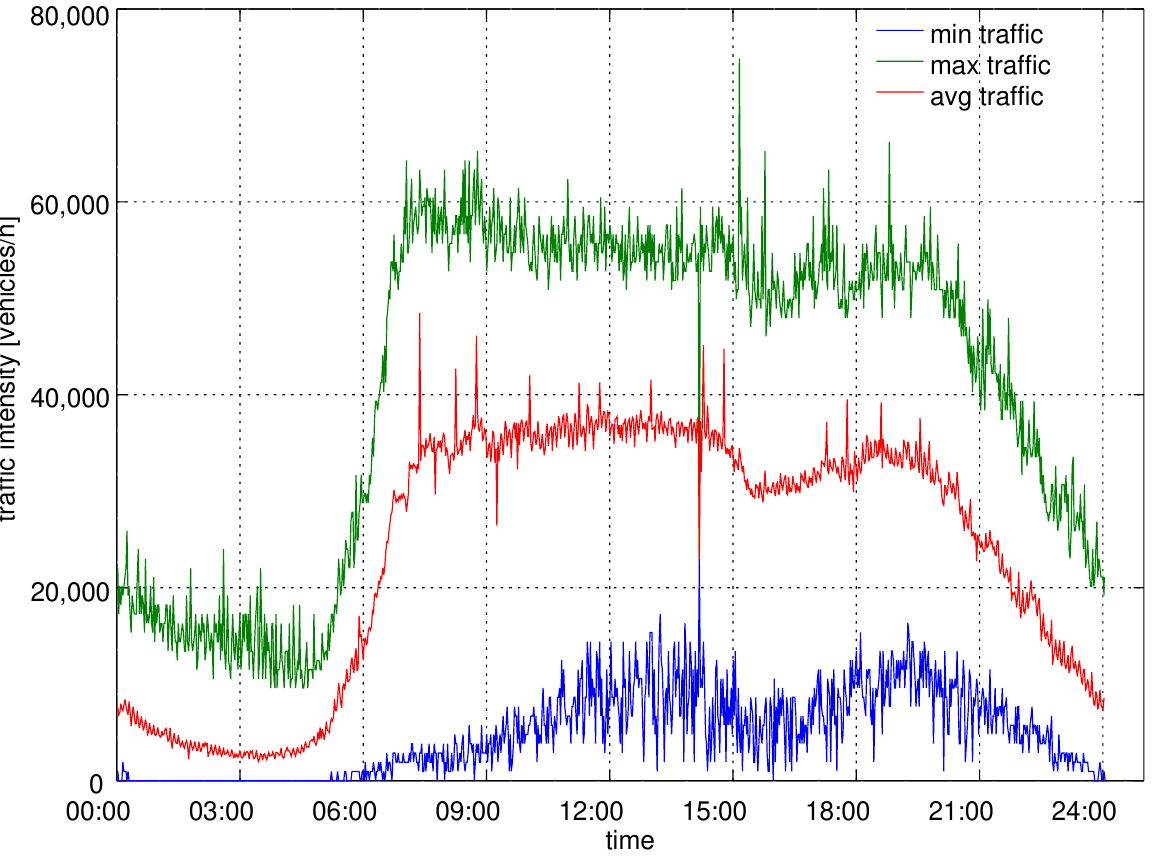
Figure 3. Traffic intensity on various